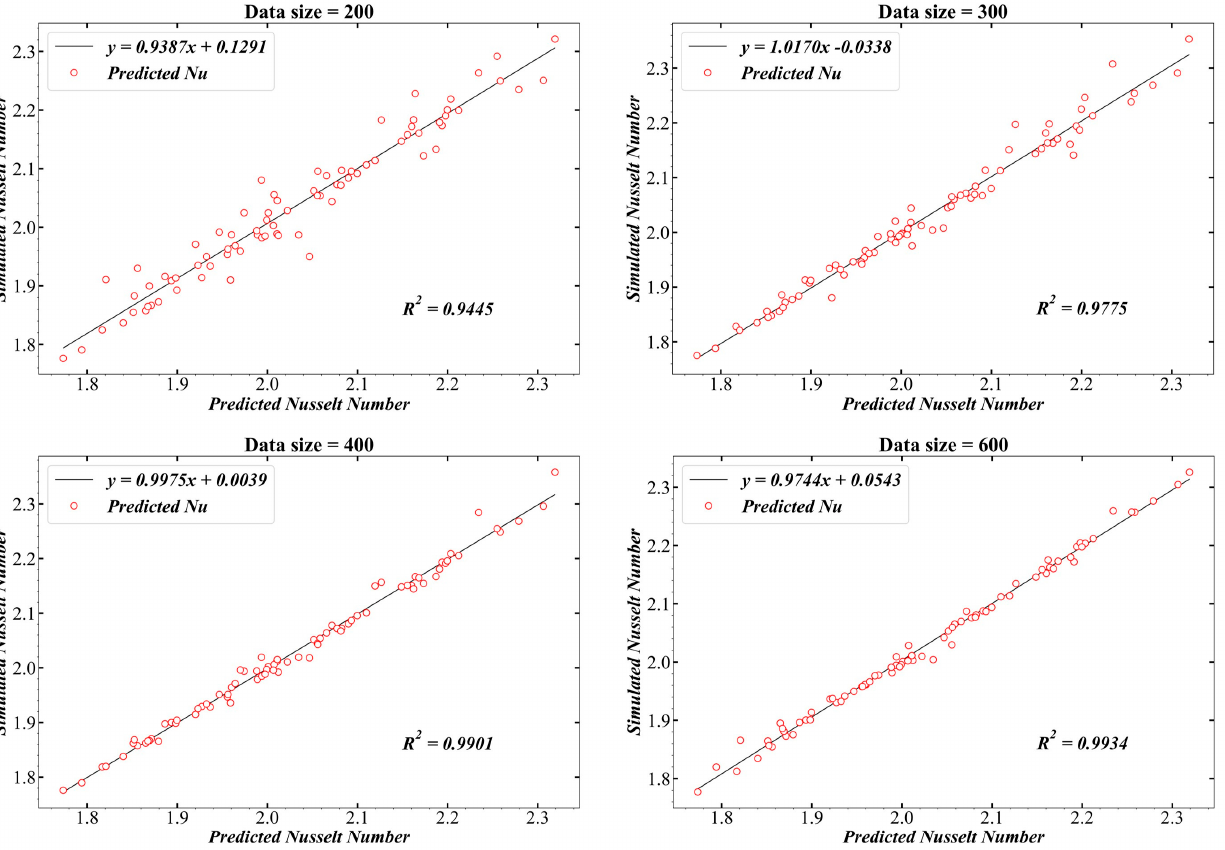
Figure 9. Comparison of predicted and simulated average Nusselt number with various data size.